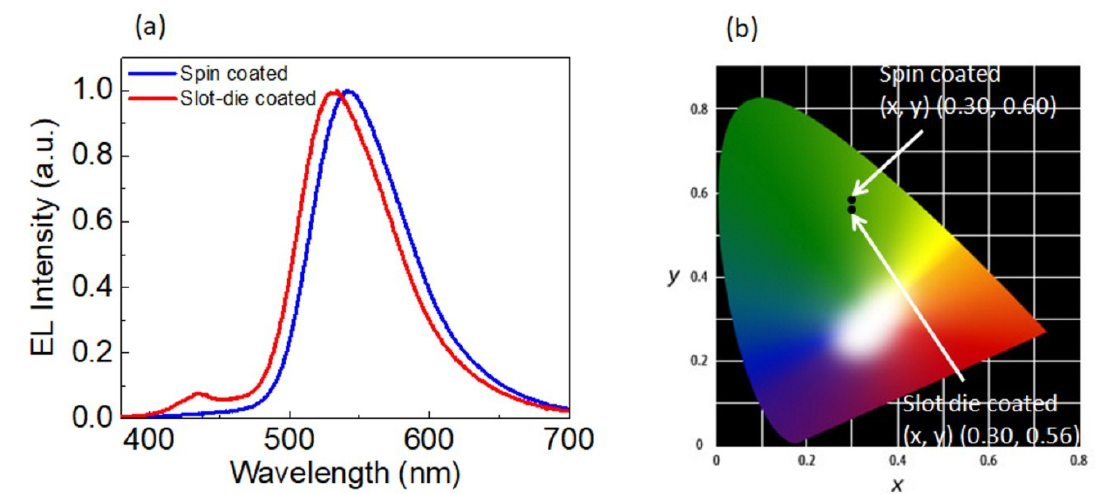
Figure 12. ( a ) Normalized EL and ( b ) chromaticity coordinates (CIE 1931) of spin-coated and slot-die coated OLEDs.